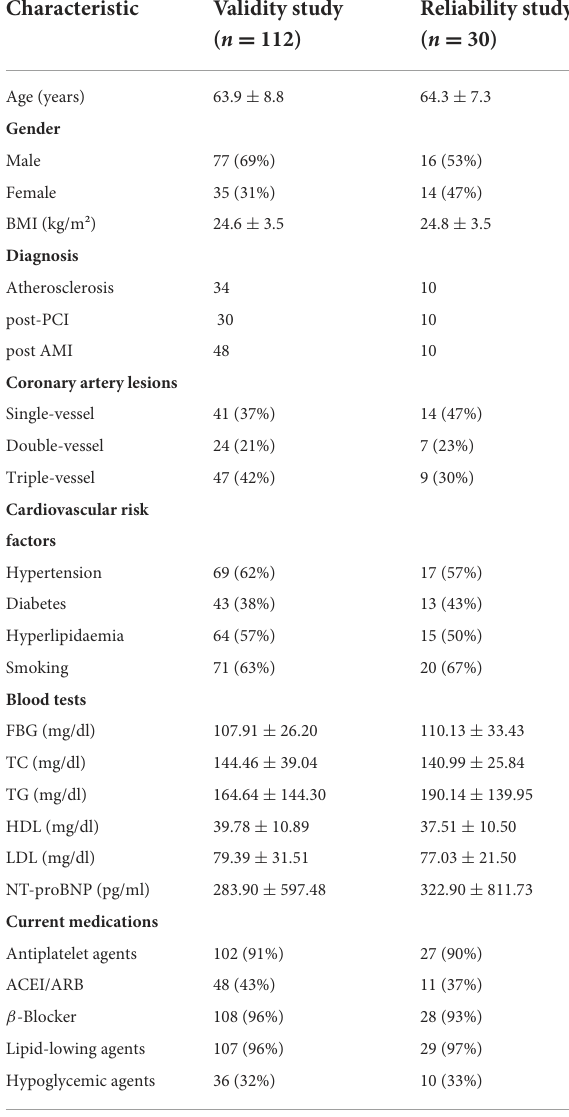
TABLE 1 Demographics characteristics of the participants. that the AUC of FTSTS, 30-s STS,and 1-min STS tests were 0.80 (sensitivity: 75.0%, specificity: 73.8%,